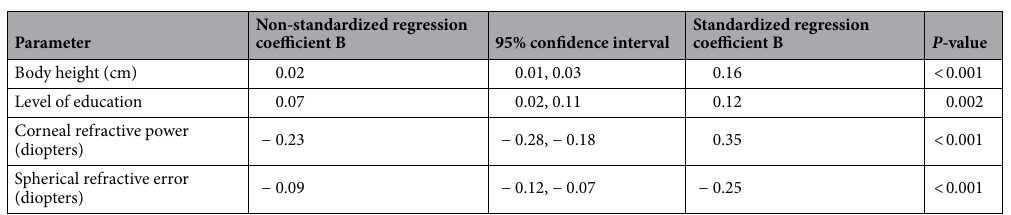
Table 3. Associations (multivariable analysis; correlation coefficient r: 0.50) between axial length and other parameters in the Ural Very Old Study.